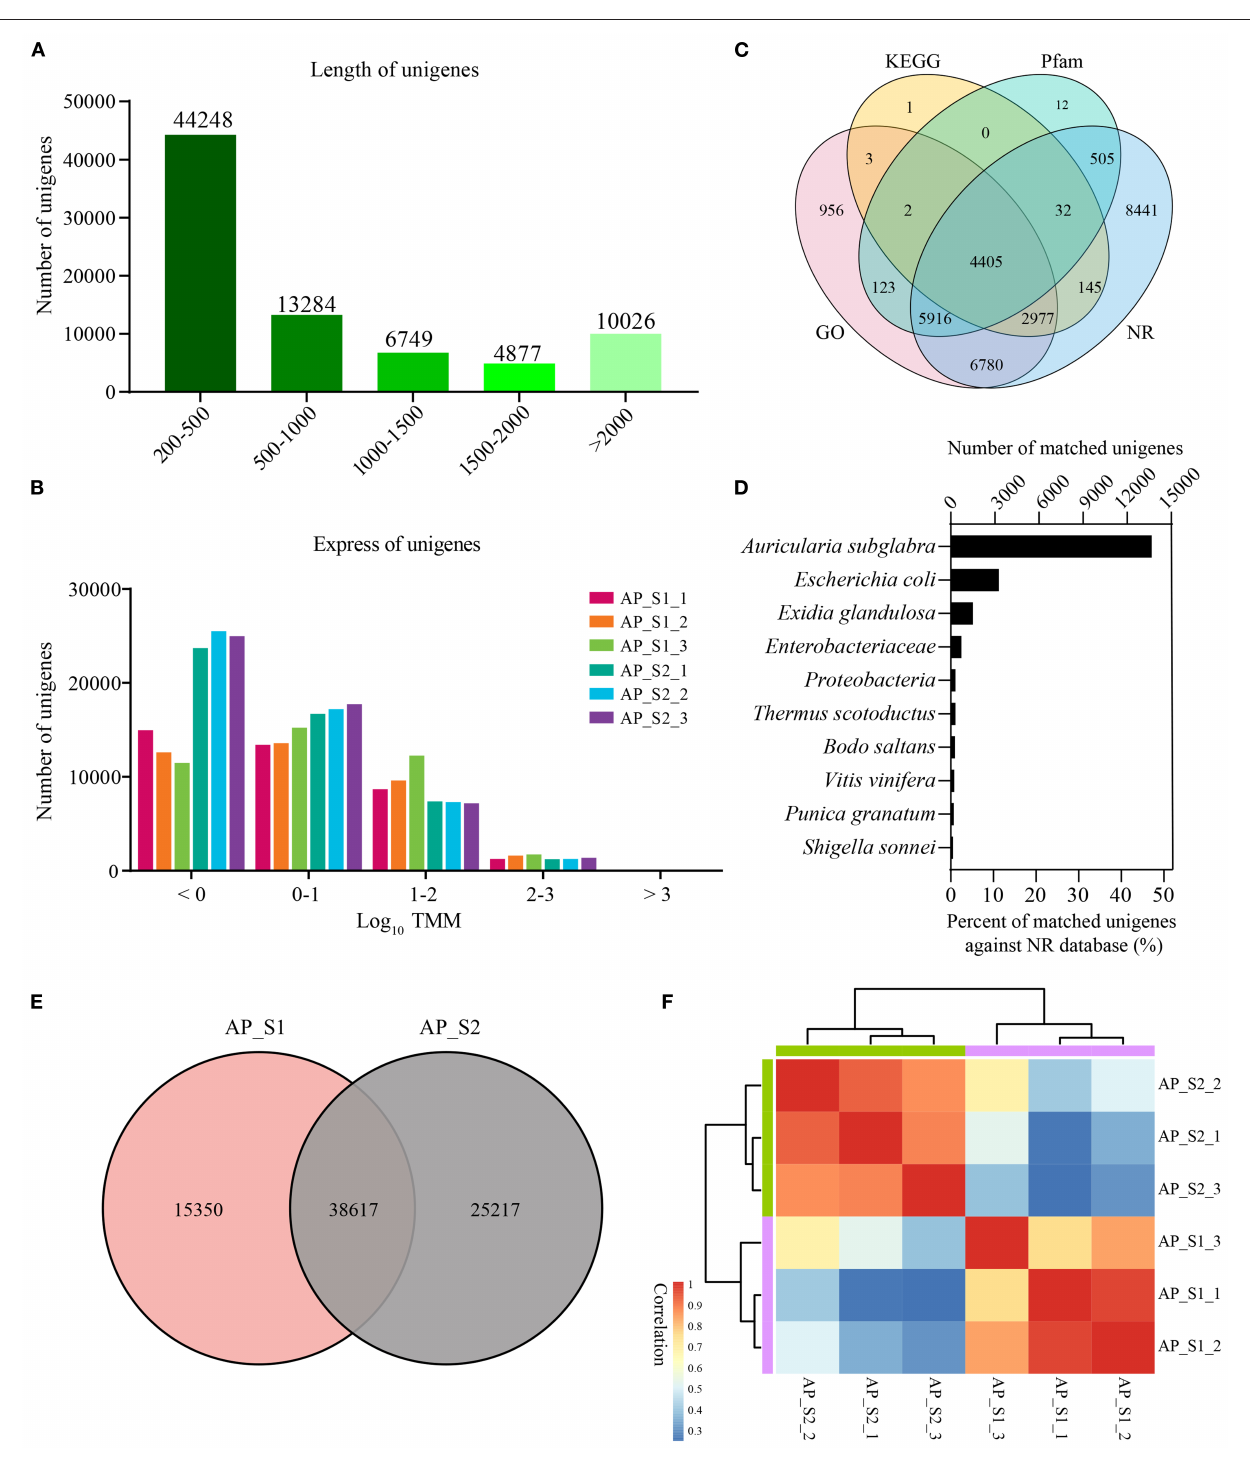
Frontiers in Nutrition | www.frontiersin.org